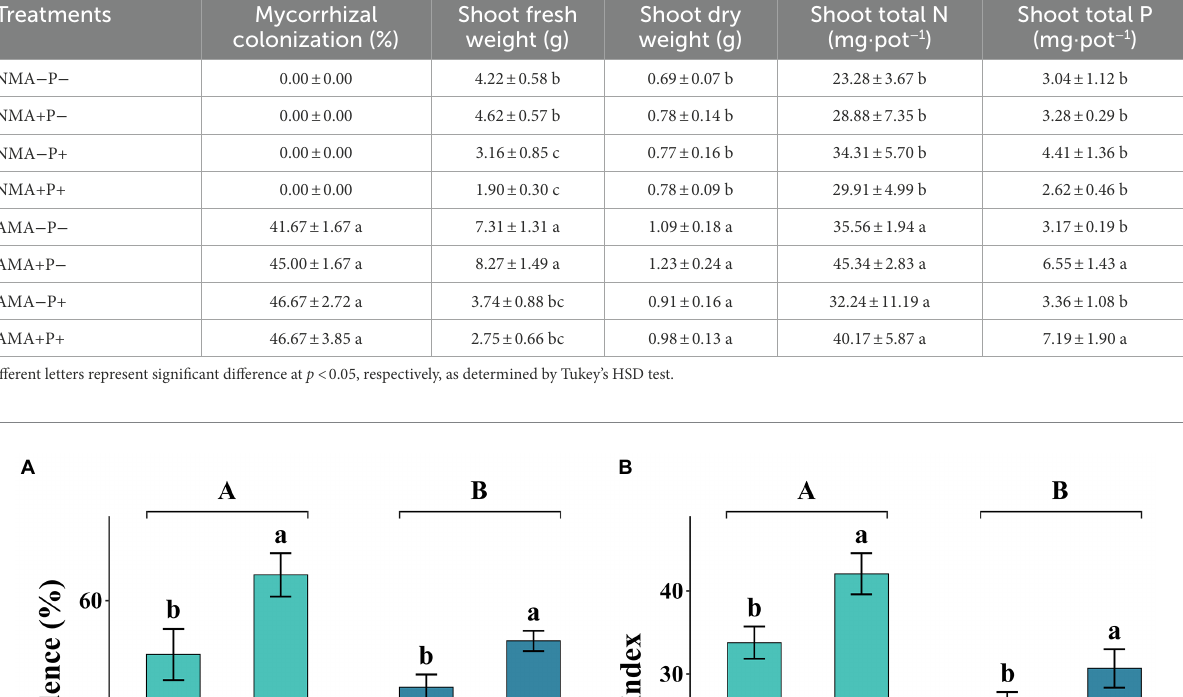
TABLE 1 AM colonization, shoot fresh weight, shoot dry weight, shoot total N and shoot total P of Medicago sativa inoculated with Rhizophagus intraradices (AM), infested with Acyrthosiphon pisum (A+) and infected with Phoma medicaginis (P+) or un-inoculated with R. intraradices (NM), un-infested with A. pisum (A − ) and un-infected with P. medicaginis (P − ). Treatments